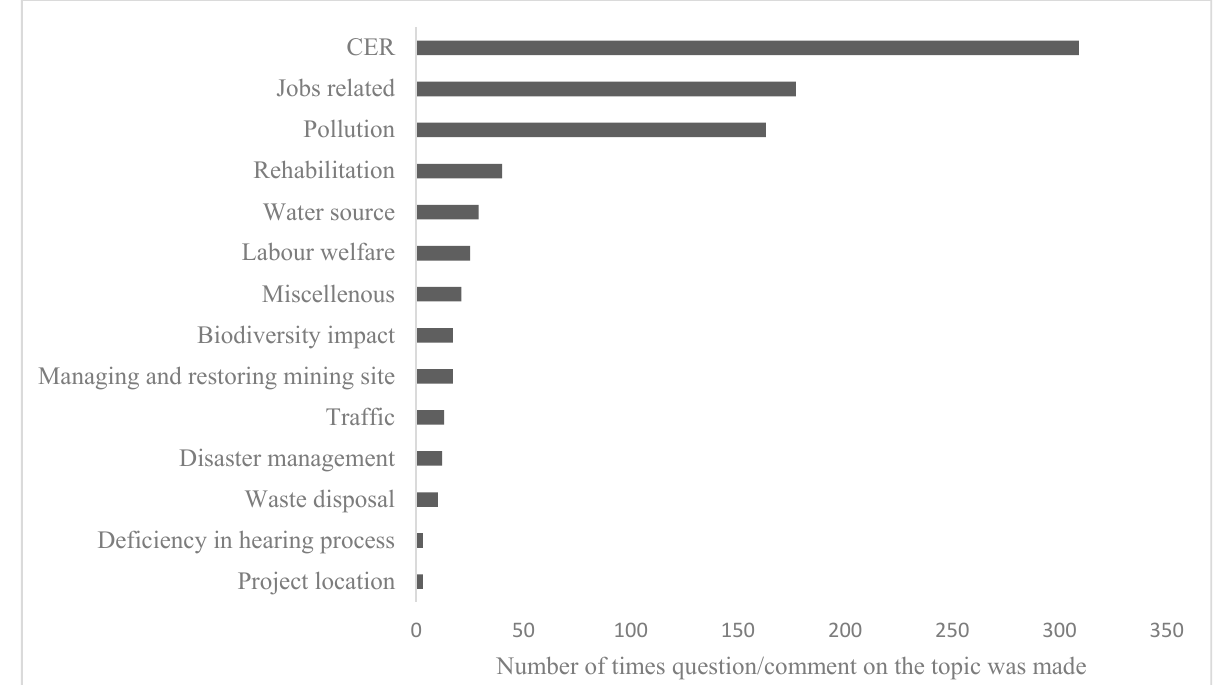
Figure 2. Spread of questions/comments from people on different topics in the 50 public hearings. Corporate Environment Responsibility (CER) is need-based activities for the local people which the project proponent is required to do around the project area.